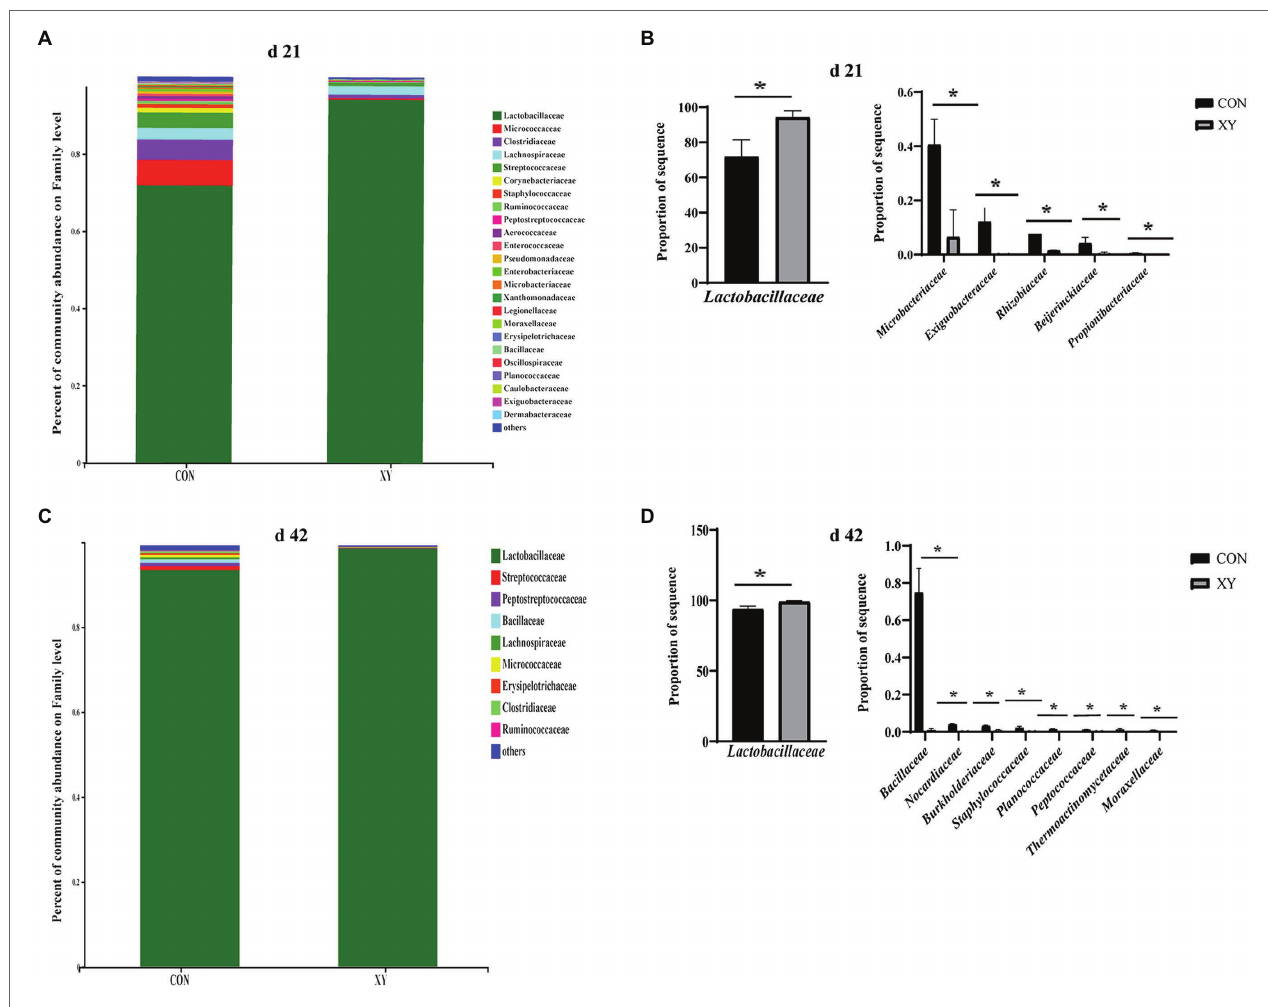
FIGURE 4 | Effects of AT-xynA on ileal microbiota composition at the family level. (A,C) Ileal microbiota composition at the family level with the relative abundance higher than 0.1% in broilers; (B,D) alterations of the abundance of bacterial families found in the ileum of broilers. CON is AT-xynA un-supplemented group; XY is 4,000 U/kg AT-xynA supplemented group. The “*” indicates a significant difference between the two treatments ( p <